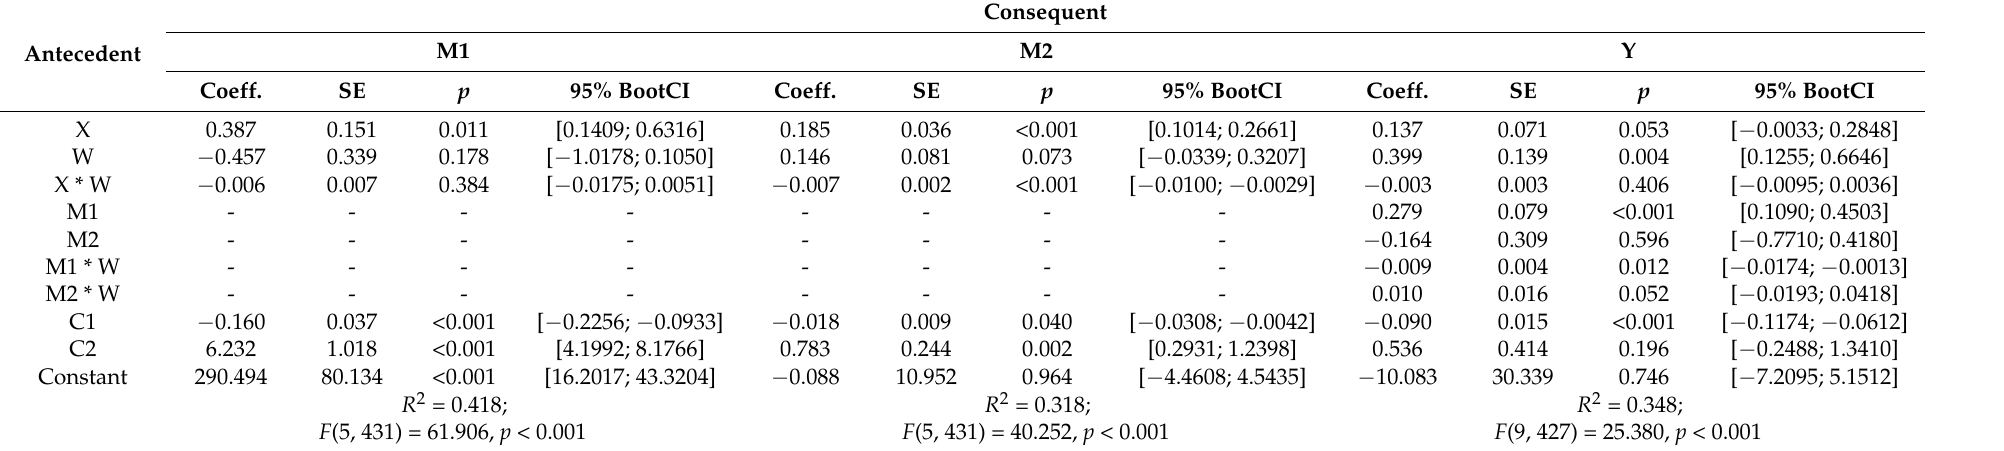
Table 3. Unstandardized coefficients and 95% bias-corrected confidence interval of the totally moderated mediation